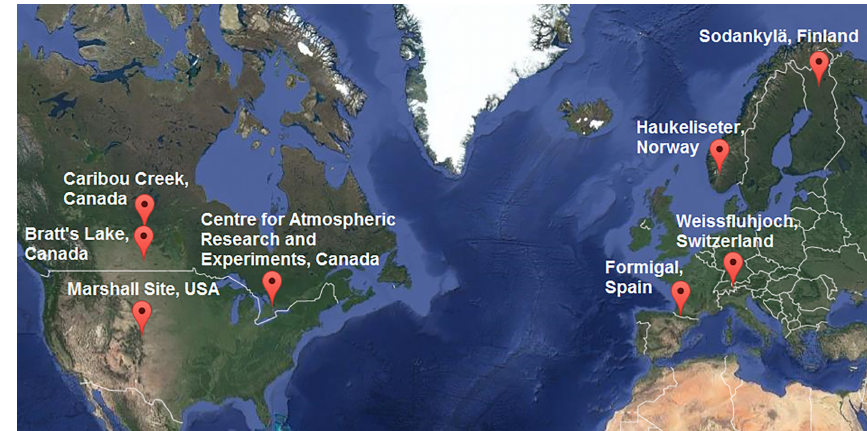
Figure 1. The SPICE intercomparison sites used in the development and evaluation of the SPICE transfer functions. (Source: base map obtained from Google Earth; data – Scripps Institution of Oceanography (SIO), US Navy, and the General Bathymetric Chart of the Oceans (GEBCO); © 2018 Google; image – Landsat/Copernicus.) Table 1. Site name (and country), abbreviation, latitude, elevation above sea level, mean daily air temperature, and relative total amounts of precipitation by phase (snow, mixed, or rain). Site Abbr. Lat Elev. Mean Relative total (country) T a Bratt’s Lake (Canada) XBK 50.20 ◦ 585m CARE (Canada) CAR 44.23 ◦ 251m Caribou Creek (Canada) CCR Formigal (Spain) FOR 42.76 ◦ 1800m Haukeliseter